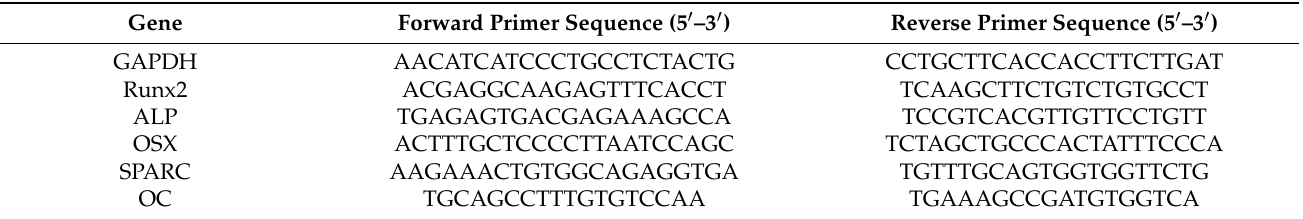
Table 2. Sequences of the primers used in RT-qPCR analysis of the expression of osteogenic genes. Gene Forward Primer Sequence (5 (cid:48) –3 (cid:48) ) Reverse Primer Sequence (5 (cid:48) –3 (cid:48)